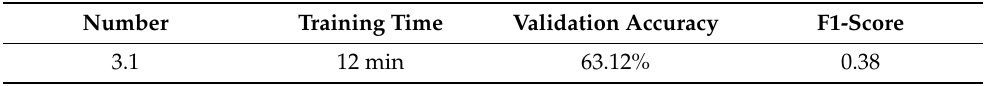
Table 6. Evaluation table for the third